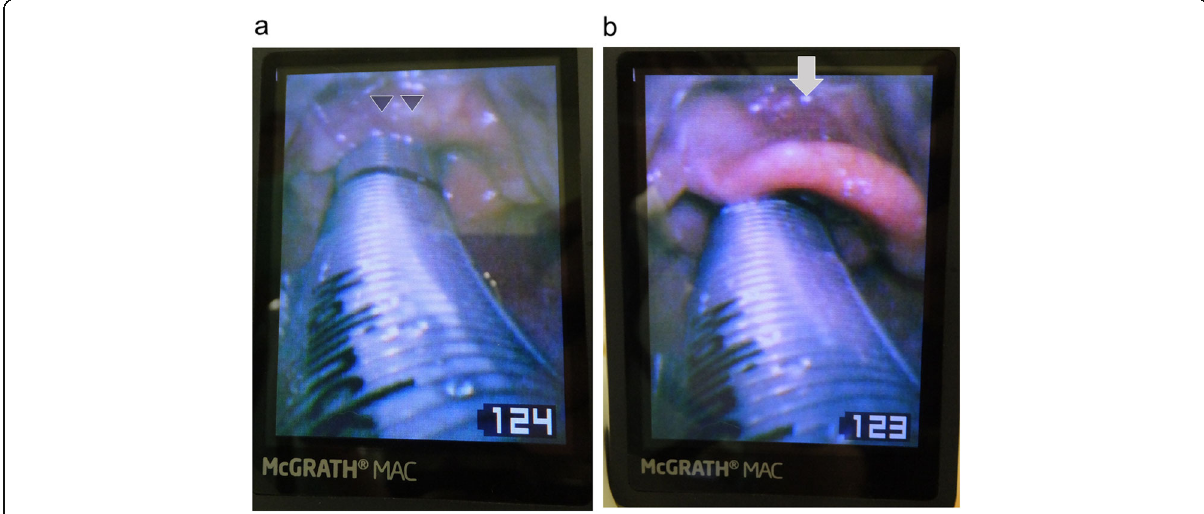
Fig. 1 Views of the larynx as seen on the screen of the McGrath videolaryngoscope. a After tracheal intubation, the epiglottis (arrowheads) is prolapsed and folded down into the laryngeal inlet. b The epiglottis has been restored to its original position by gentle glottic exposure with the McGrath videolaryngoscope blade. Only slight submucosal hemorrhage can be observed on the surface of the epiglottis (arrow), and swelling has not